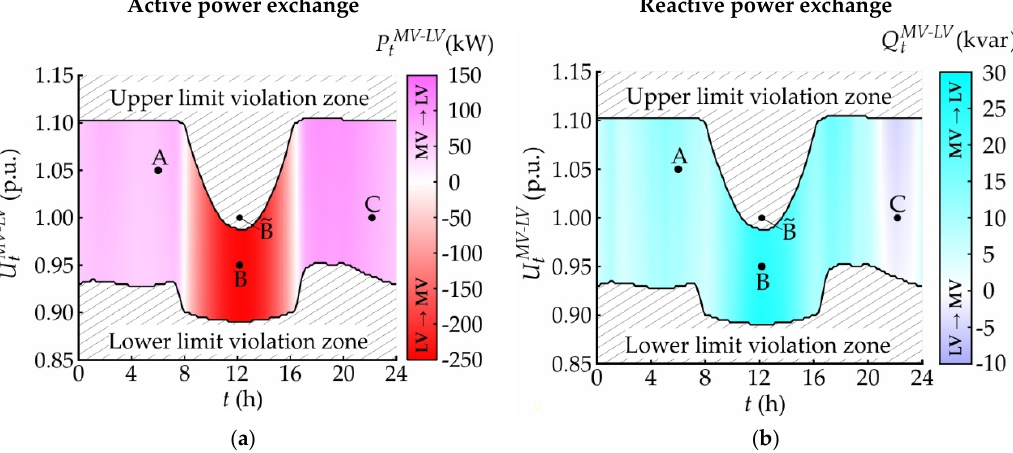
Figure 10. Daily behavior of the rural LV grid for various voltages at the MV–LV boundary node: ( a ) MV–LV active power exchange; ( b ) MV–LV reactive power exchange.